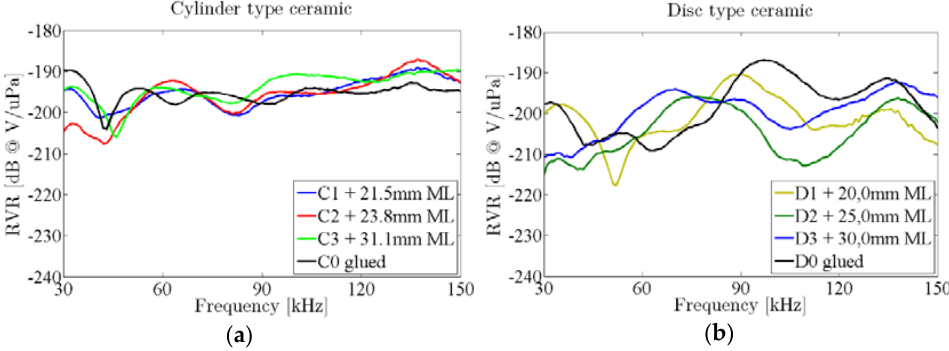
Figure 13. RVR of ceramics with ML (color lines) and without it (black line), glued to the vessel. ( a ) Cylinder type ceramic; ( b ) Disc type ceramic.